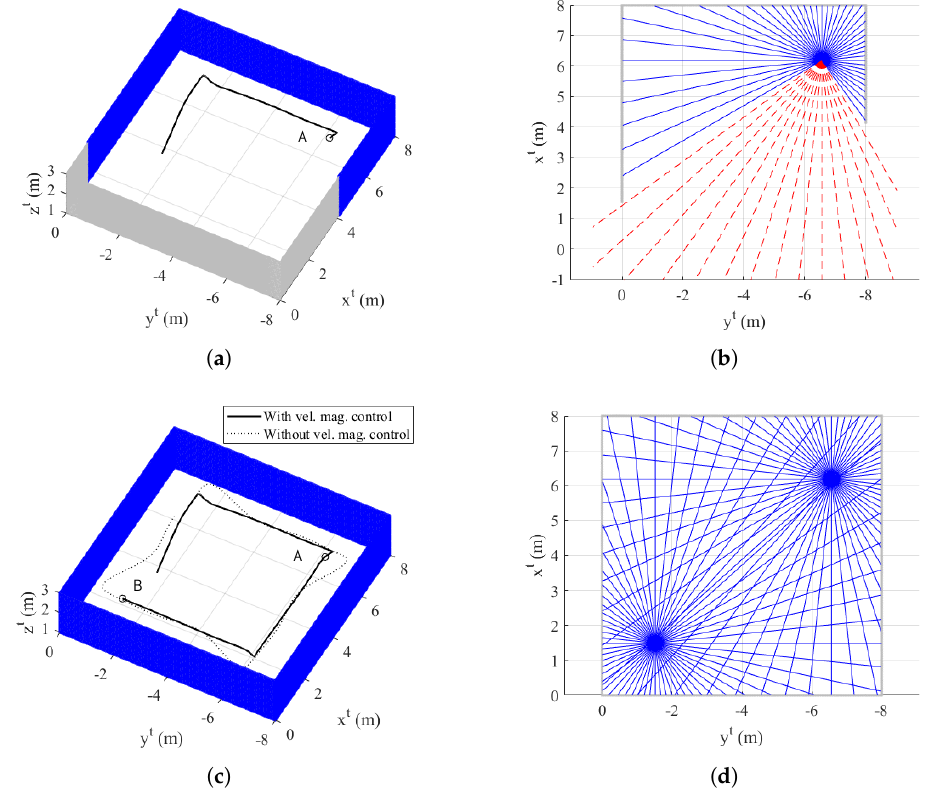
Figure 6. Simulation I result: ( a ) trajectory of the quadrotor and mapping at t = 16.0 s (azimuth: − 62 ◦ and elevation: 50 ◦ , tangent–plane coordinate system); ( b ) exploration completion check at t = 16.0 s; ( c ) trajectory of the quadrotor and mapping at t = 32.0 s (azimuth: − 62 ◦ and elevation: 50 ◦ , tangent–plane coordinate system); and ( d ) exploration completion check at t = 32.0 s. Simulation 1